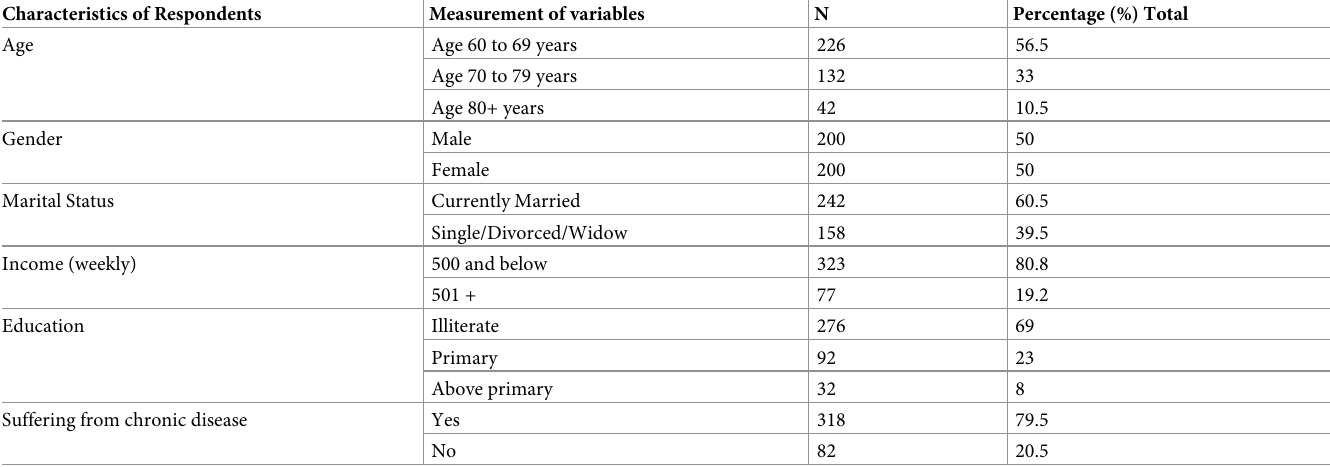
Table 1. Description of socio-demographic and health condition variables used in analysis with their percentage in total. (N = 400). Characteristics of Respondents